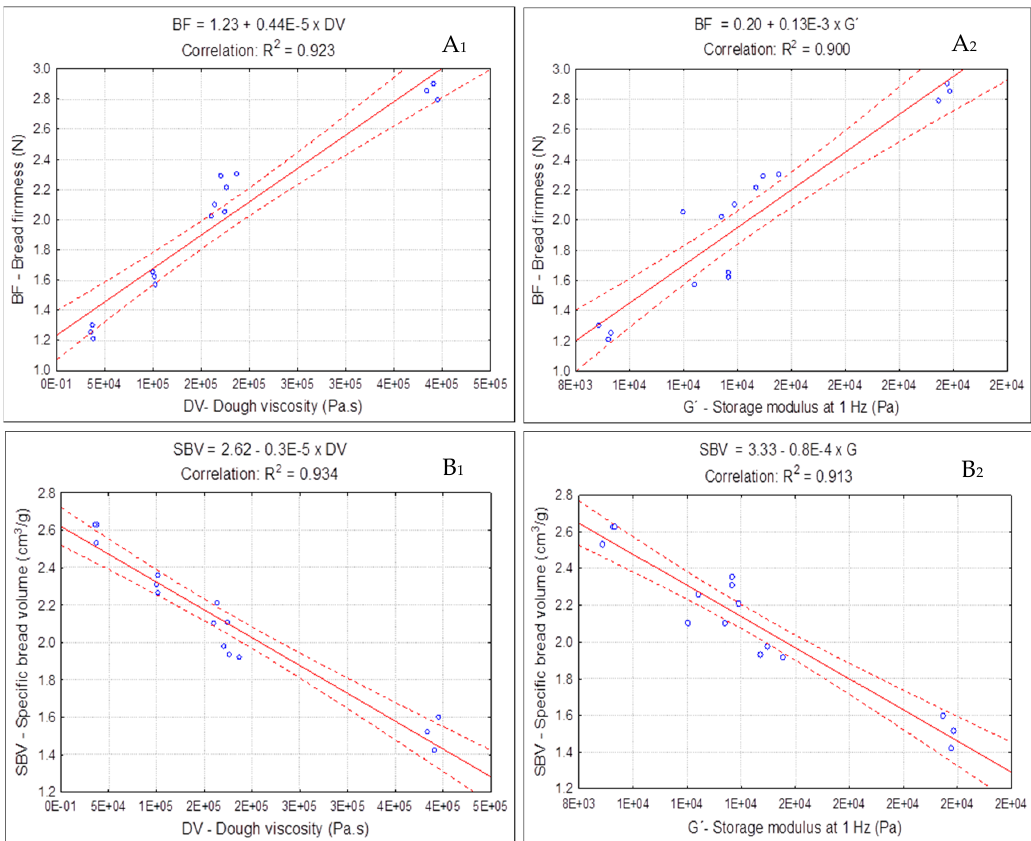
Figure 5. Linear relationship between bread quality attributes (BF—bread firmness and SBV—specific bread volume) with dough rheology properties (DV—dough viscosity and G’—elastic modulus, at 1 Hz): ( A 1 )—BF vs. DV; ( A 2 )—BF vs. G’; ( B 1 )—SBV vs. DV; ( B 2 )—SBV vs. G’.